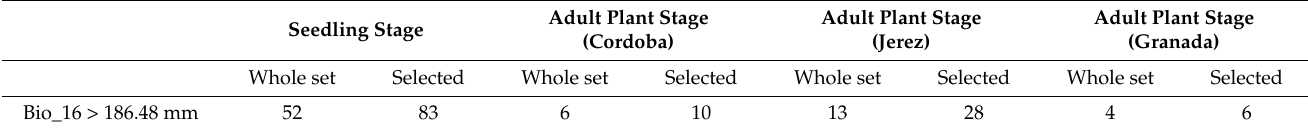
Table 3. Frequency of resistant landraces (%) to leaf rust (disease severity ≤ 10%) in the whole set and in the selected landraces at seedling and adult plant stages at three locations with the threshold values established for precipitation of the wettest quarter (Bio_16).